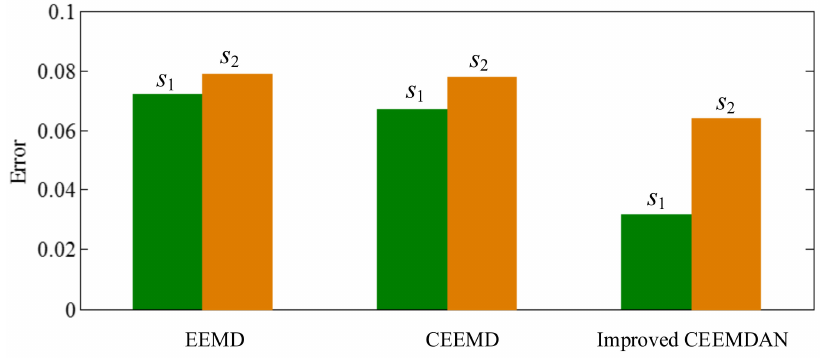
Figure 21. The errors of decomposition results of EEMD, CEEMD and improved